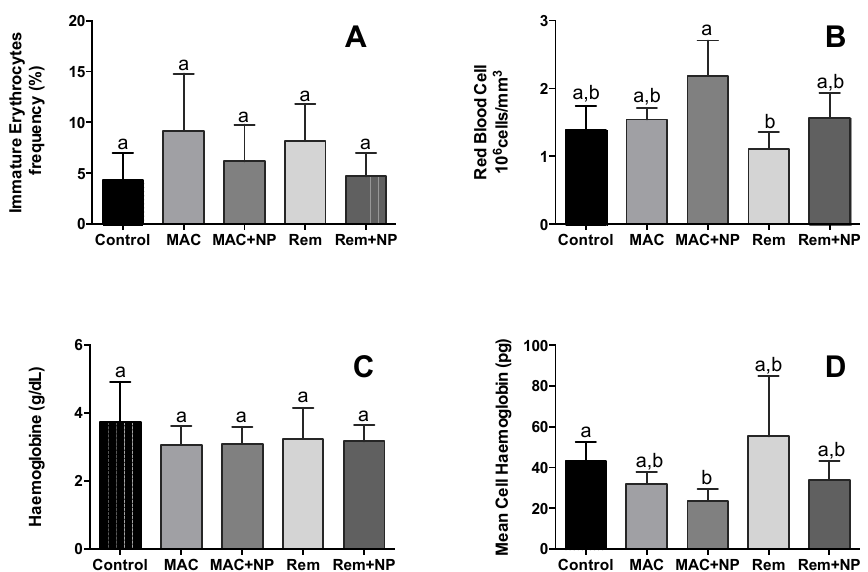
Figure 3. Haematological dynamics in S. maximus exposed to different metallic mixtures, with and without nanoparticles, for 7 consecutive days. ( A ) Immature erythrocyte frequency (%), ( B ) red blood cell count (10 6 cells/mm 3 ), ( C ) haemoglobin (g/dL), and ( D ) mean cell haemoglobin (pg). MAC—maximum concentrations allowable for effluents discharges; Rem − MAC concentrations after remediation processes; MAC + NP—maximum concentrations allowable for effluent discharges plus Ag-NP and Au-NP; Rem + NP—MAC concentrations after remediation processes plus Ag-NP and Au-NP. Different lower-case letters denote significant differences ( p < 0.05). Columns correspond to mean values and error bars represent the standard deviation.